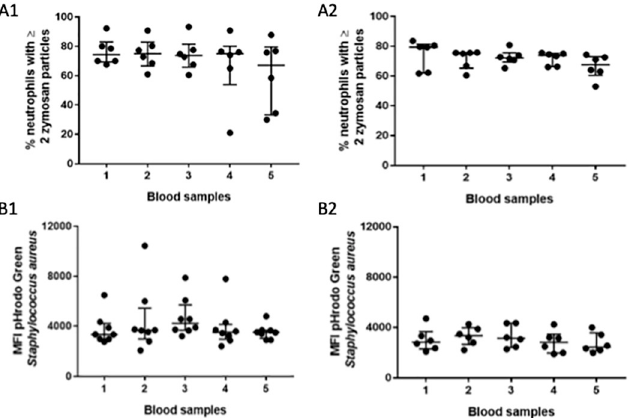
Fig 1. Blood neutrophil phagocytosis. Phagocytosis was quantified on neutrophils isolated from whole blood using a light microscopic assay of opsonized zymosan uptake: [A1] n = 6 (cohort 1) and [A2] n = 6 (cohort 2). Separately, phagocytosis was quantified whole blood using flow cytometric evaluation of internalized of pHrodo green Staphylococcus aureus bioparticles: [B1] n = 8 (cohort 1) and [B2] n = 6 (cohort 2). Data are presented on scatter plots with median (middle bar) and interquartile range (whiskers). The Friedman test with Dunn’s post-hoc multiple comparisons was used to compare values between sample 1 and samples 2–5. Wilcoxon’s matched pairs signed rank test was used to compare the right, ventilated lung (sample 4) and the left, deflated lung (sample 5). Abbreviations: MFI: median fluorescence intensity.